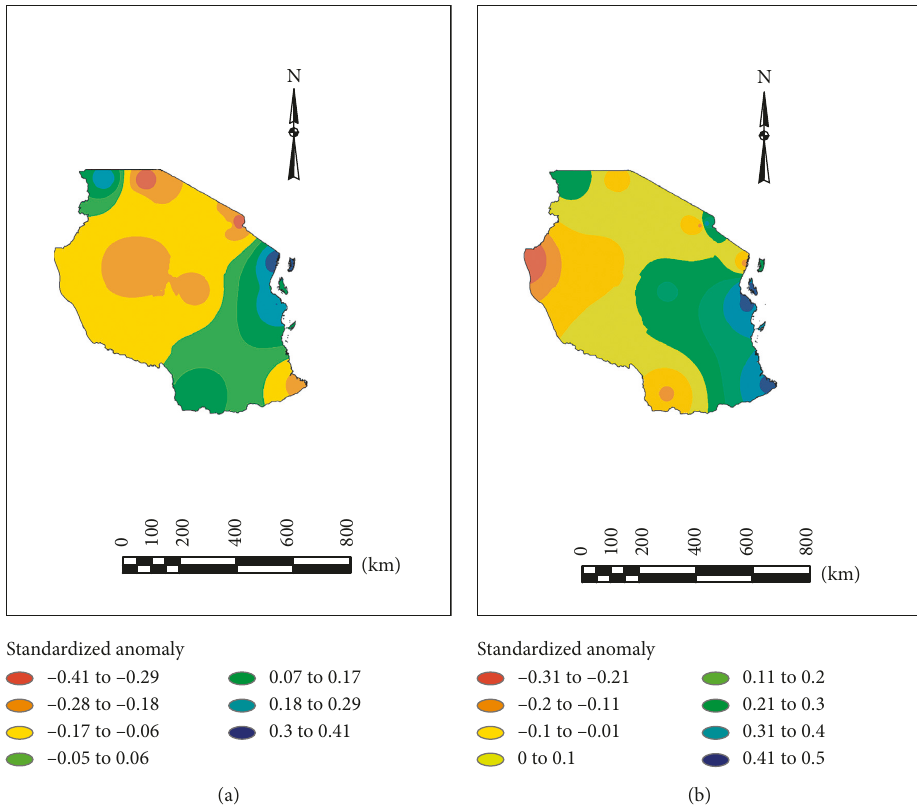
Figure 5: The spatial pattern of (a) the second EOF mode (EOF-2) and (b) the third EOF mode (EOF-3) of the mean heavy rainfall during the MAM season based on 1980–2010